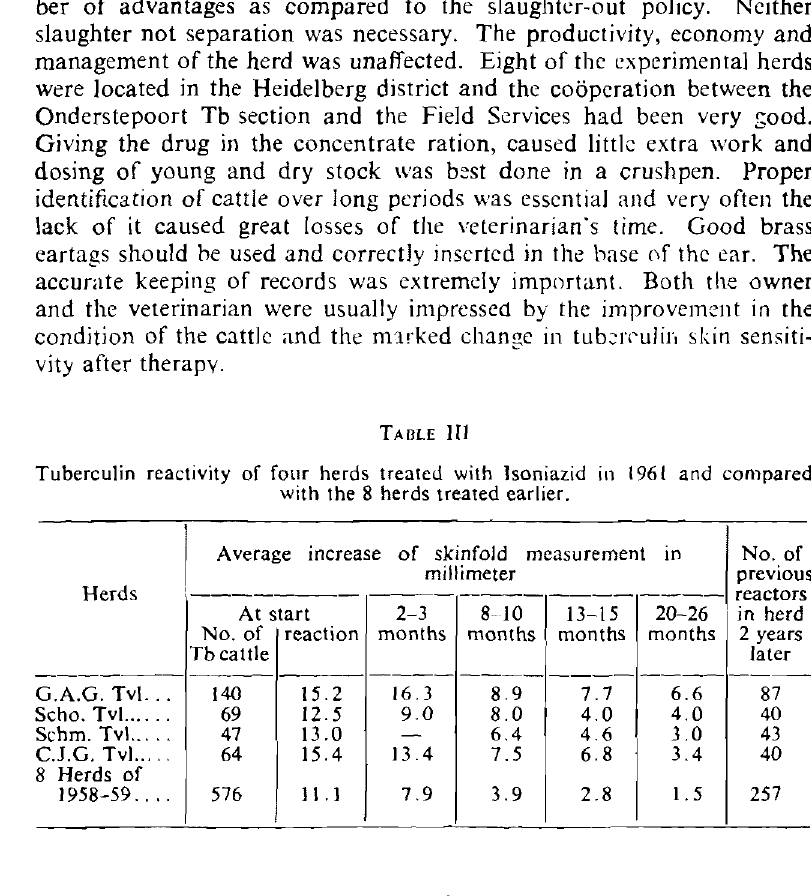
Tuberculin reactivity of five herds which started Isoniazid treatment in